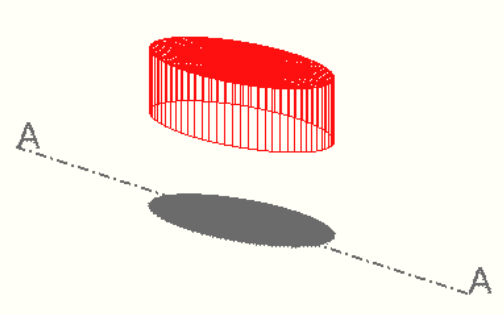
Figure 23: 3-D surfaces and stress contours of σ z near the surface: Boussinesq’s solution on the top and the second order solution on the